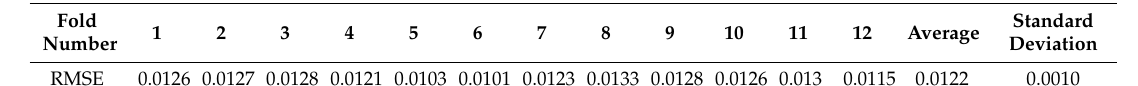
Table 2. Results of the k-fold